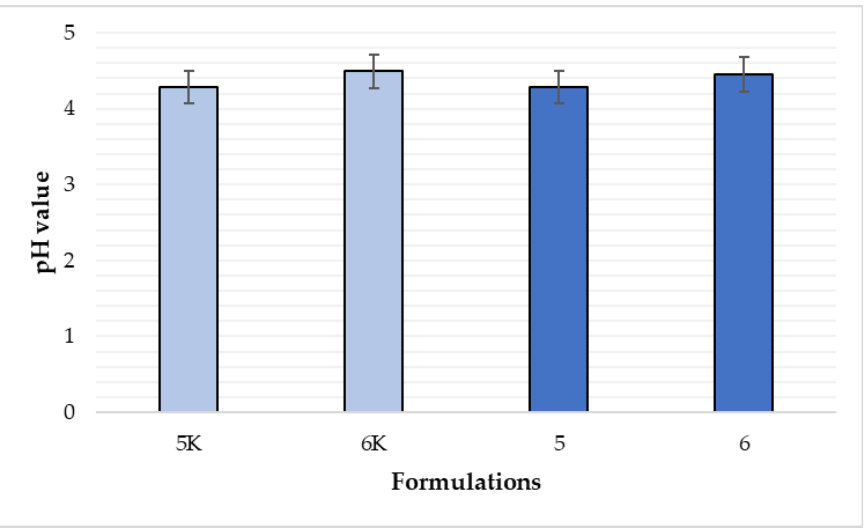
Figure 17. Comparison of pH values by composition (n = 6). The composition values are given in Table 1. p < 0.05 between compositions 5 and 6.